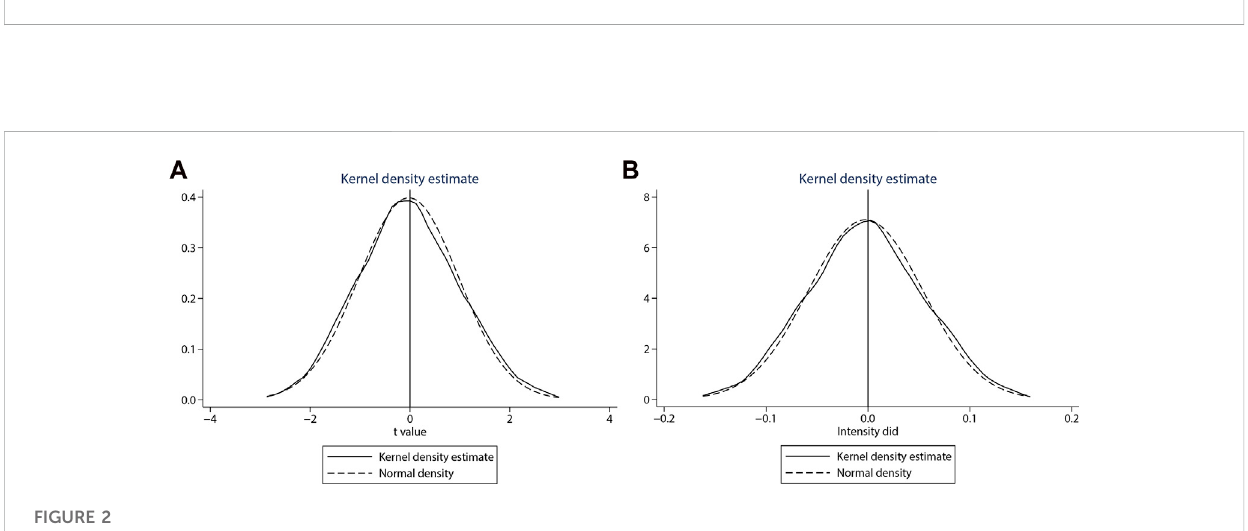
the policy. Before 2018, FDI fl uctuated around 0; its 95% con fi dence interval contains 0. In 2018 and after 2018, FDI showed a signi fi cant increase, and its 95% con fi dence interval is signi fi cantly different from 0, indicating that FDI showed a signi fi cant increase after implementing the policy. However, a partof the interval containing 0in 2019 still passed the 5% signi fi cance level